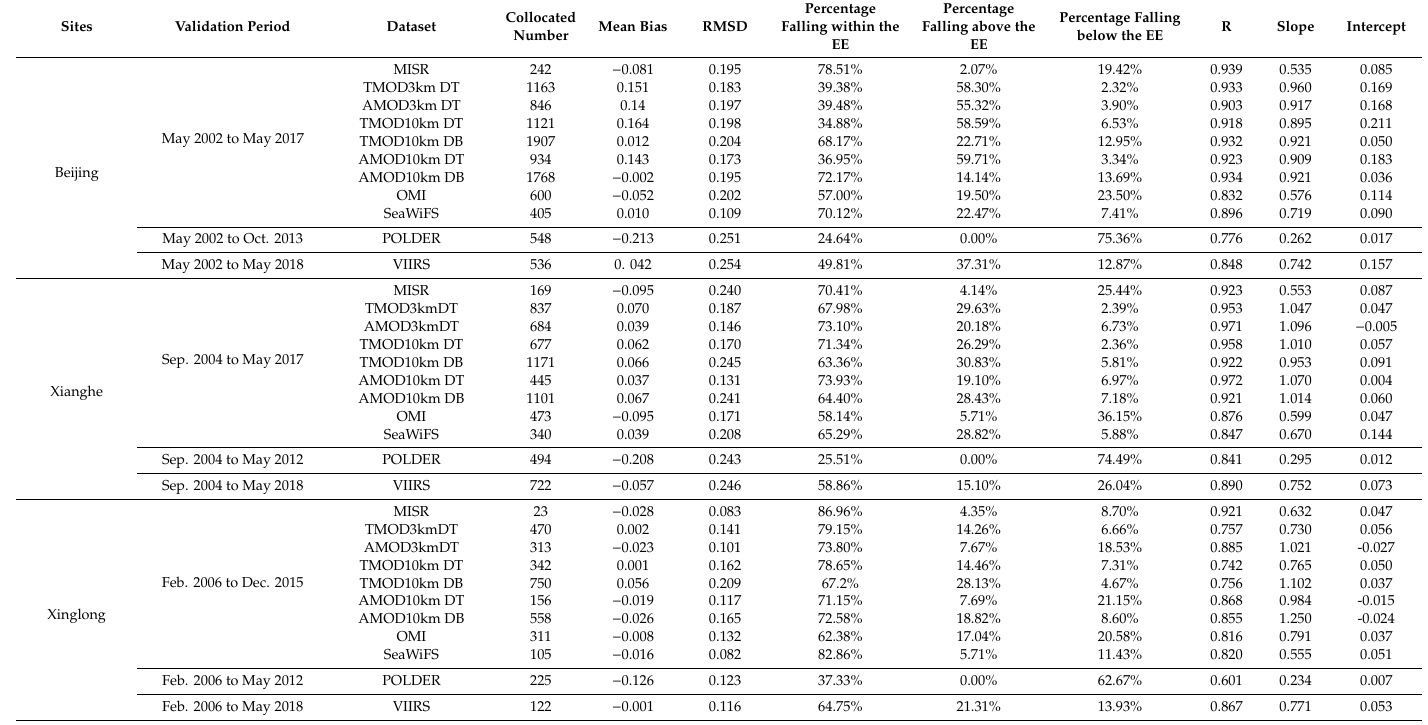
Table 1. The validation periods and data statistics at the Beijing, Xianghe, and Xinglong sites, including the number of satellites and AERONET (Aerosol Robotic NETwork) matchups, the mean bias (defined such that positive values indicate an overestimation of satellite retrieval), the root mean square di ff erence (RMSD), the linear correlation coe ffi cient (R), the slope and the intercept of linear regression, and the percentages of satellite AODs falling within the expected error (EE), above the EE, and below the